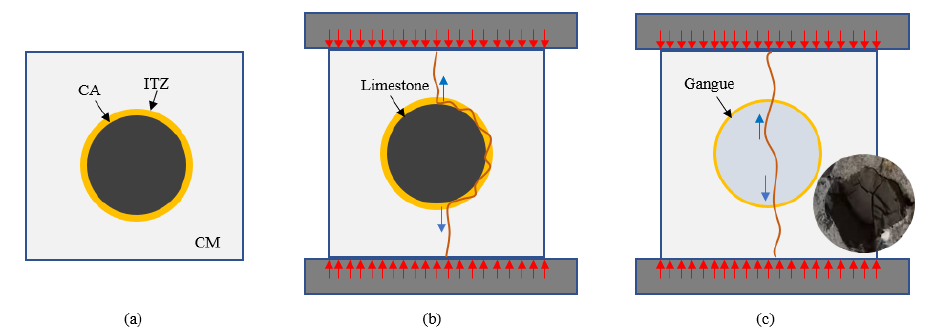
Figure 11. Relationship between aggregate type/crack path and ITZ. ( a ) The relationship between Coarse Aggregate, Cement Mortar and ITZ. ( b ) Crack propagation path in limestone concrete. ( c ) Crack propagation path in gangue